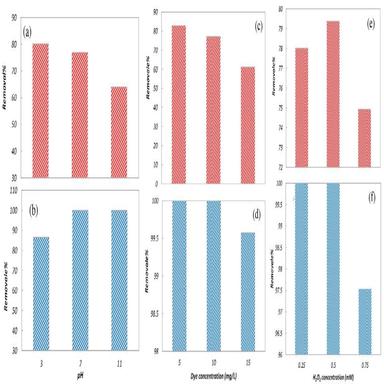
(a,b) The effect of initial pH, (c,d), the effect of dye concentration, and (e,f) the effect of H2O2 concentration on DR-80 and MB removal efficiency.